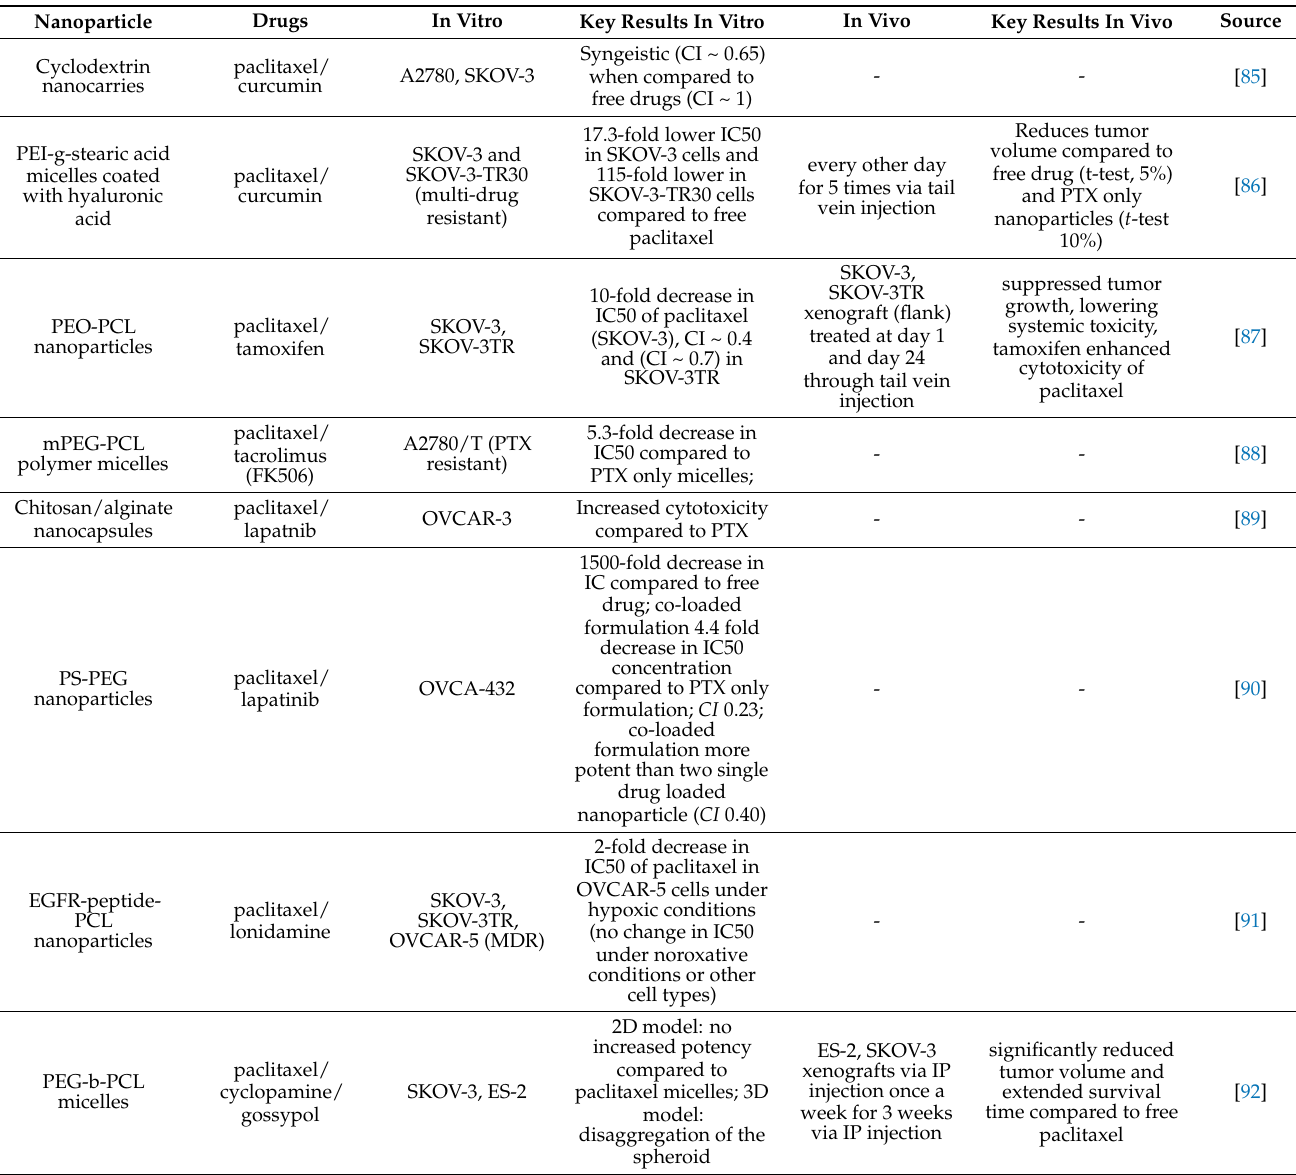
Table 2. Polymer nanocarrier formulations of paclitaxel-based drug